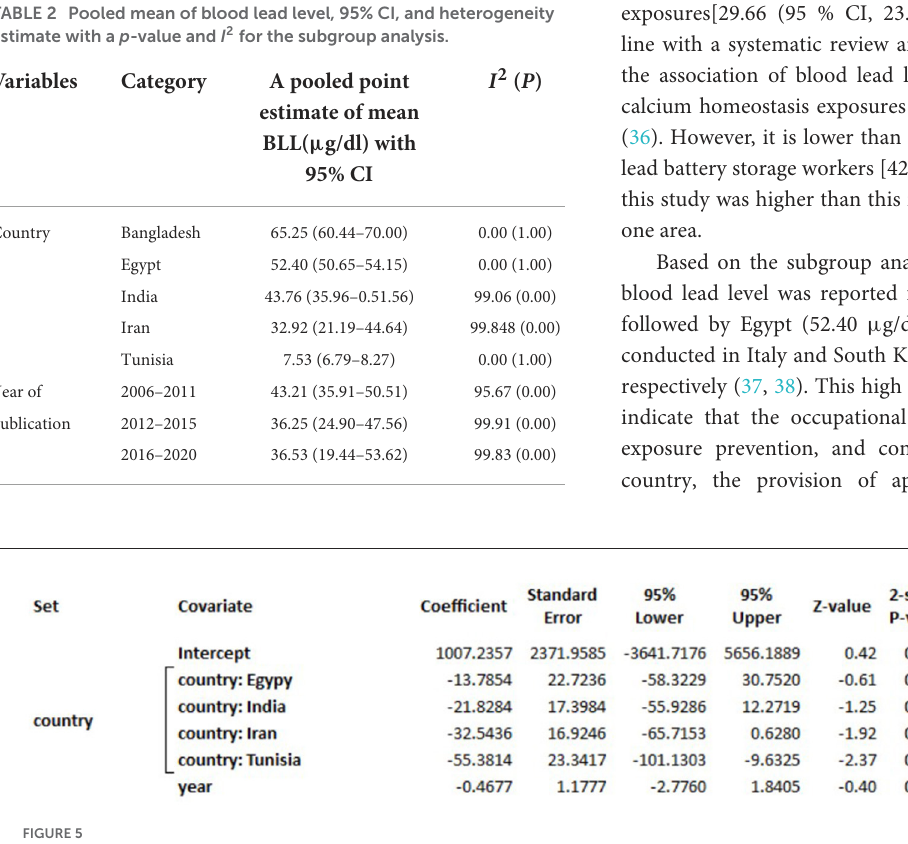
FIGURE5 Meta-Regression of the pooled mean BLL among lead battery factory workers in LMIC 2022 ( n = 18).